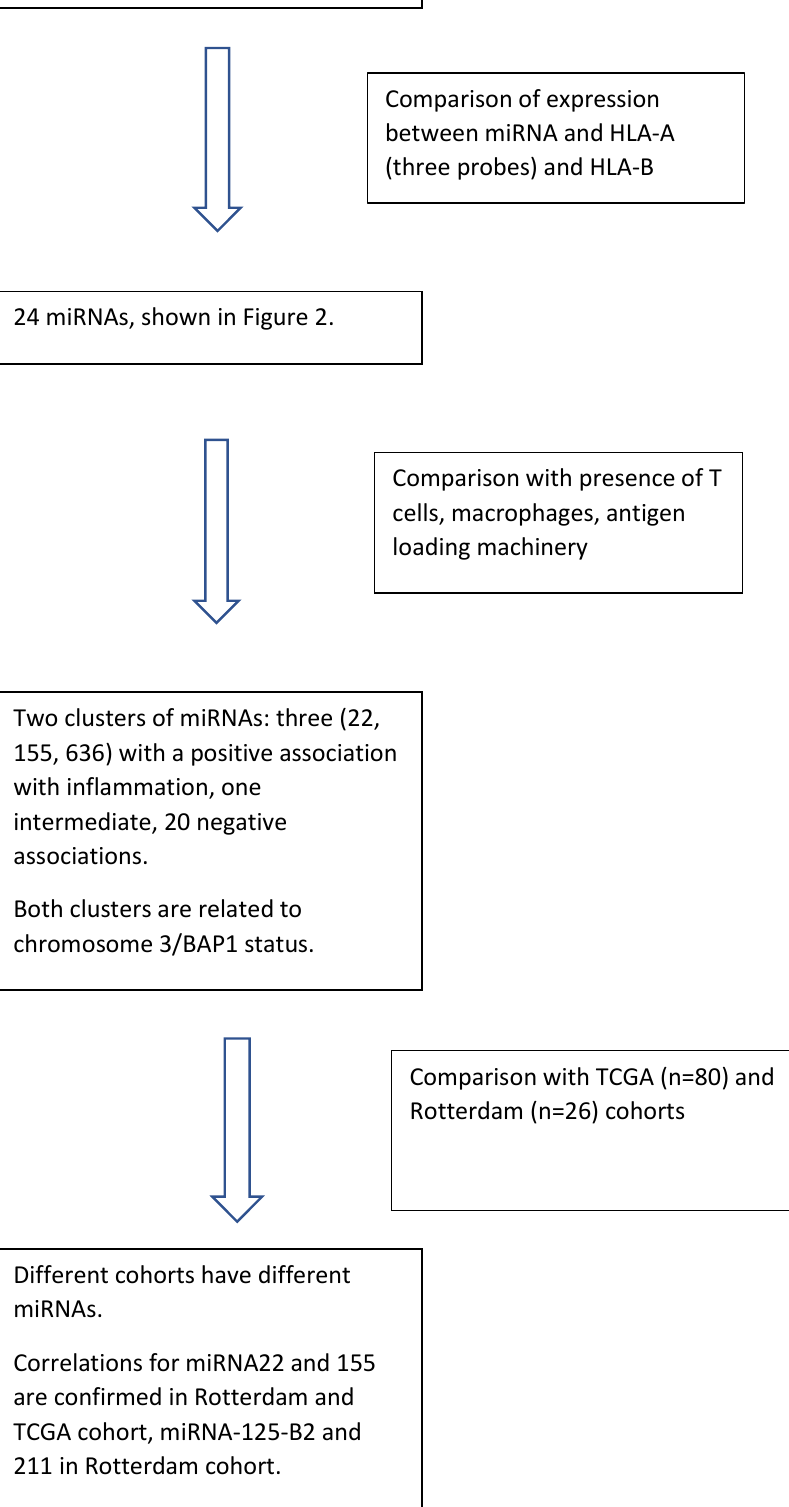
Figure 1. Schedule for analyses.